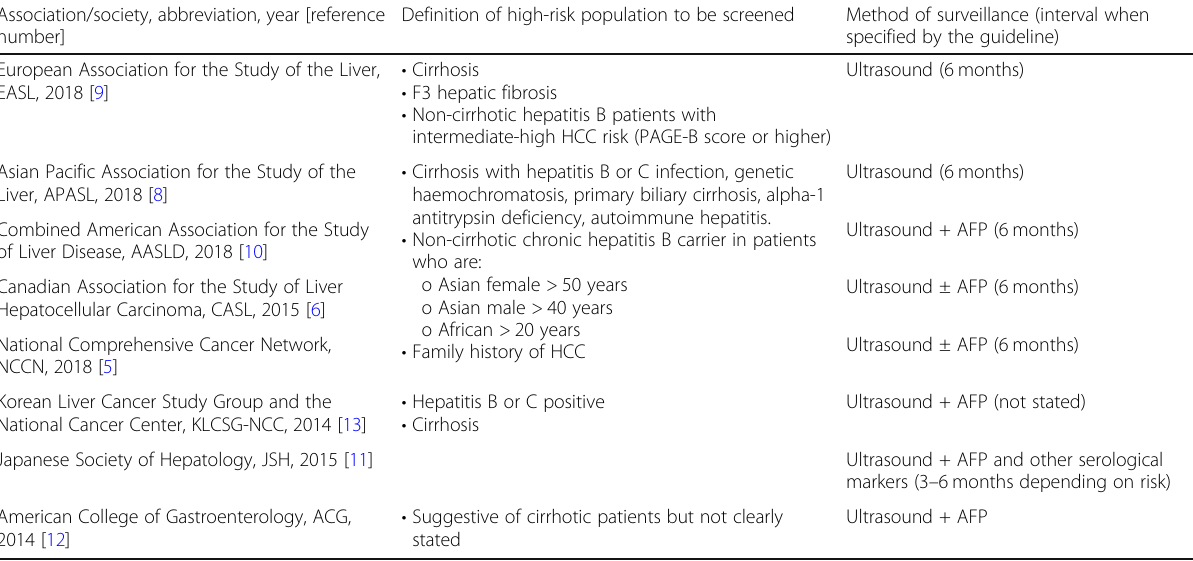
Table 1 Summary of guidelines for hepatocellular carcinoma (HCC) screening protocols Association/society, abbreviation, year [reference